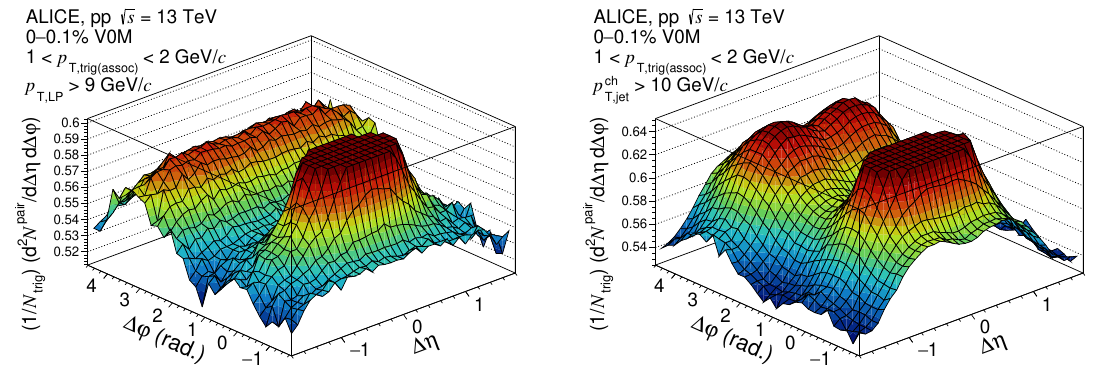
Figure 4 . Two-dimensional correlation functions as a function of ∆ η and ∆ ϕ in high-multiplicity events including a selection on the